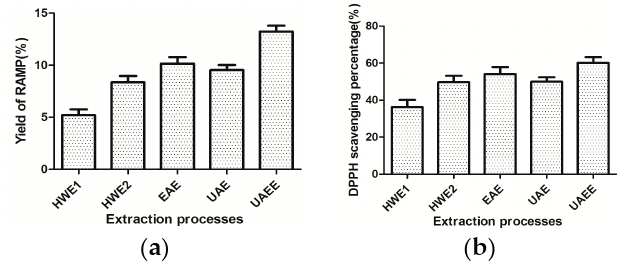
Figure 4. The yield ( a ) and DPPH scavenging percentage ( b ) of RAMP of different extraction processes.